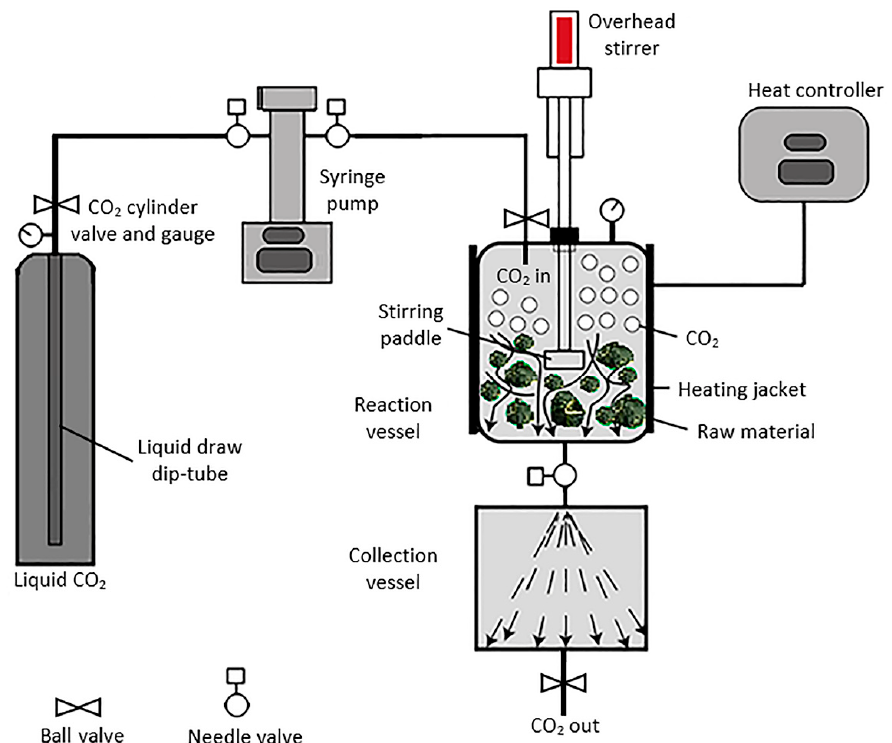
Figure 1. A typical supercritical fluid extraction system.